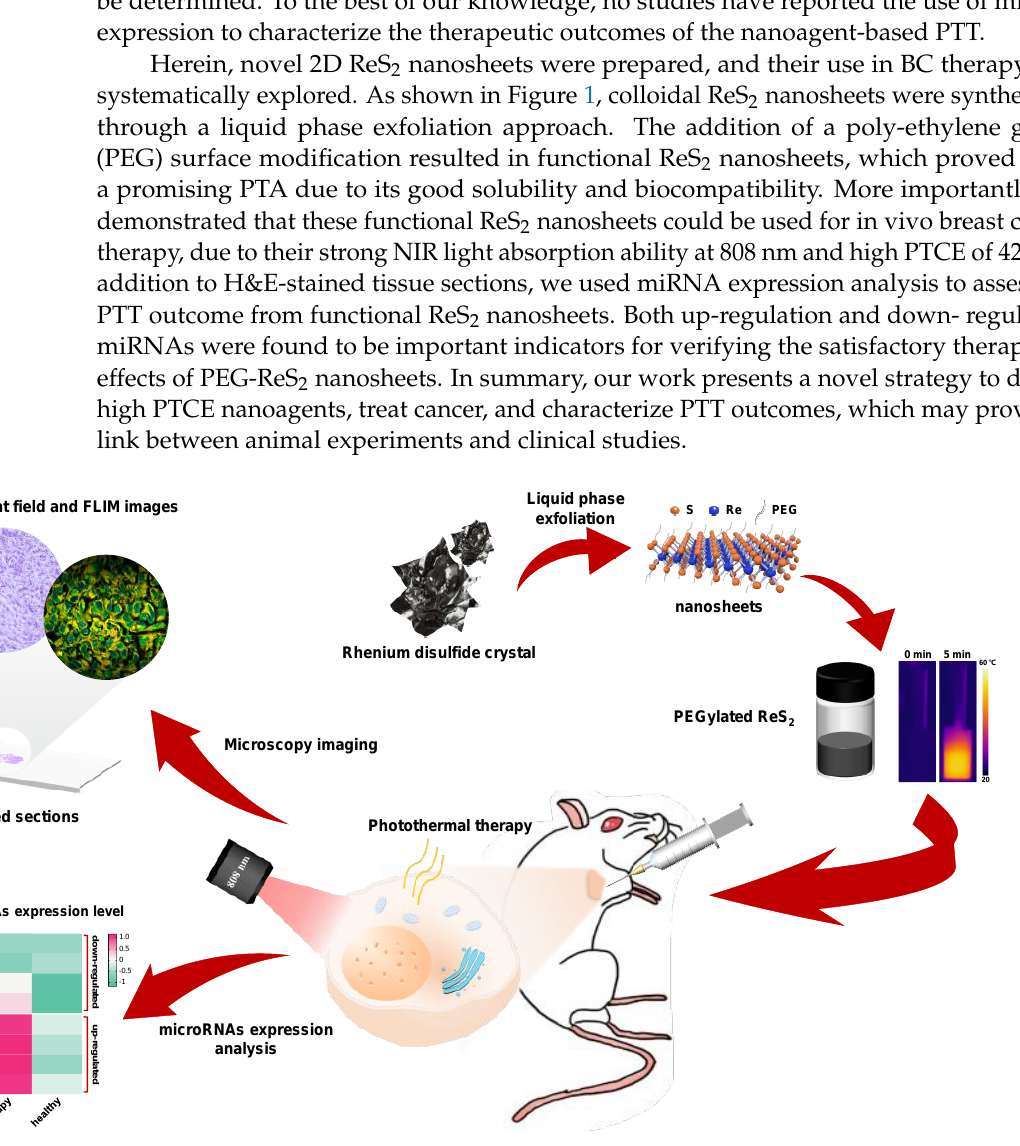
Figure 1. Schematic illustration of PEG − ReS 2 nanosheets employed for in vivo breast cancer therapy study.